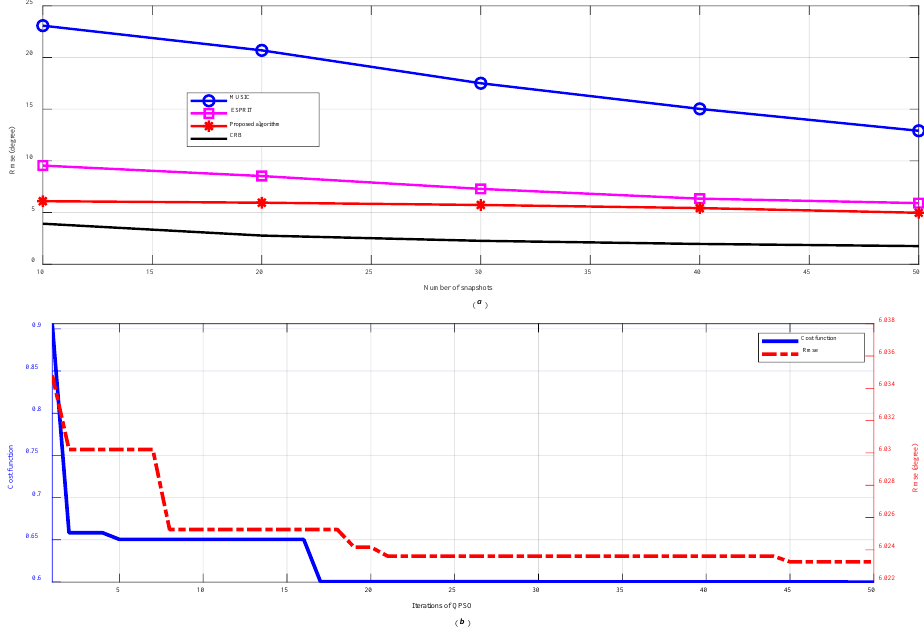
Figure 4. ( a ) RMSE versus number of snapshots (signals with different SNRs). ( b ) The cost function and the RMSE versus the number of iterations.